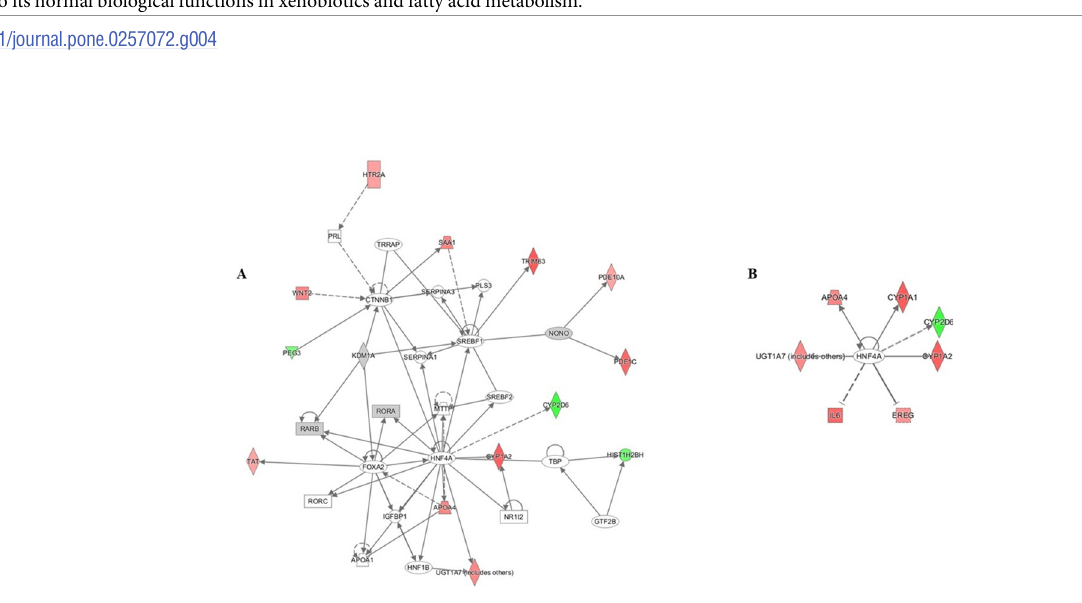
PLOS ONE | https://doi.org/10.1371/journal.pone.0257072 October 1,